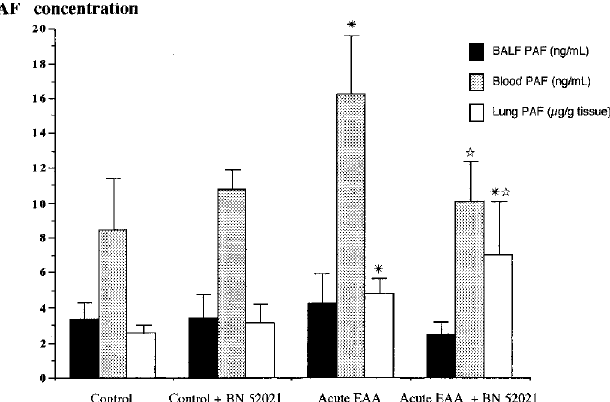
FIG. 2. PAF concentrations in the experimental groups. Data are mean ± SD of triplicate measurements from three guinea pigs/group and were analysed by two-way analysis of variance and multiple mean comparison test. Asterisks ( w ) represent significant differences ( P < 0.05) with respect to control group and stars ( q ) significant differences ( P < 0.05) with respect to the acute EAA